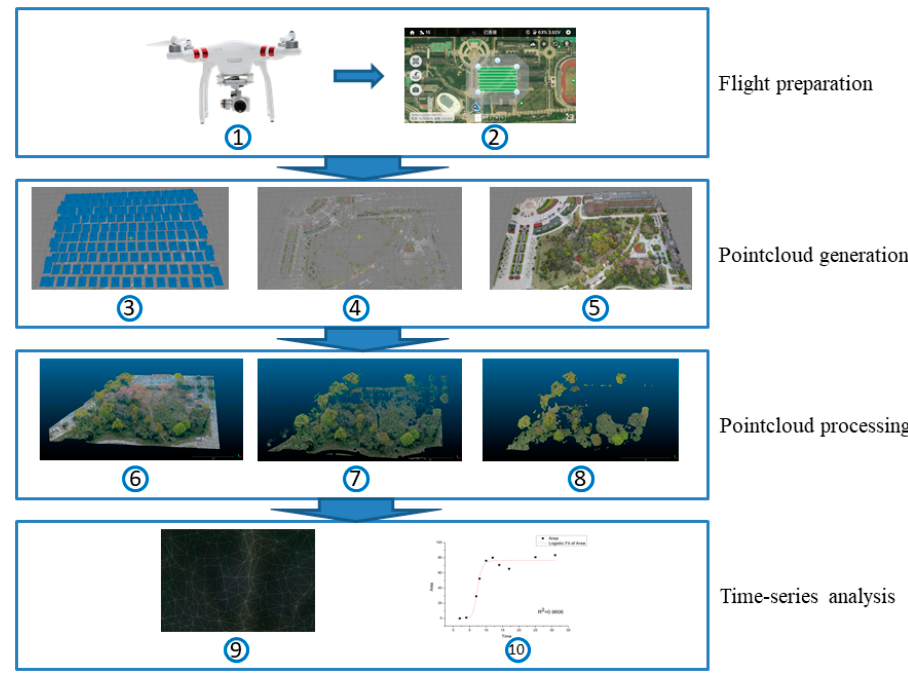
Figure 1. The general workflow of this research. Step 1, prepare drones including battery check and flight permission; Step 2, make flight mission plan, including covering area, overlap rate and shooting interval; Step 3, import images into Agisoft; Step 4, align images and generate sparse pointcloud; Step